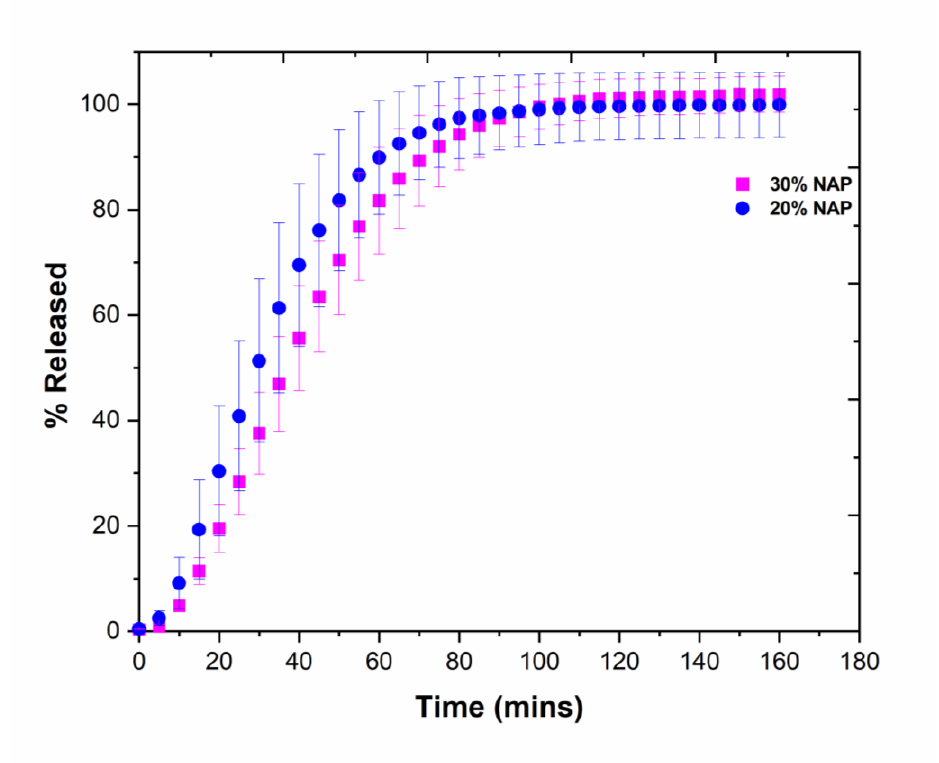
Figure 7. Release profile of NAP from 3D-printed tablets containing the 20% and 30% NAP deter- mined in phosphate buffer pH 7.4 ( n = 3). mined in phosphate buffer pH 7.4 ( n =